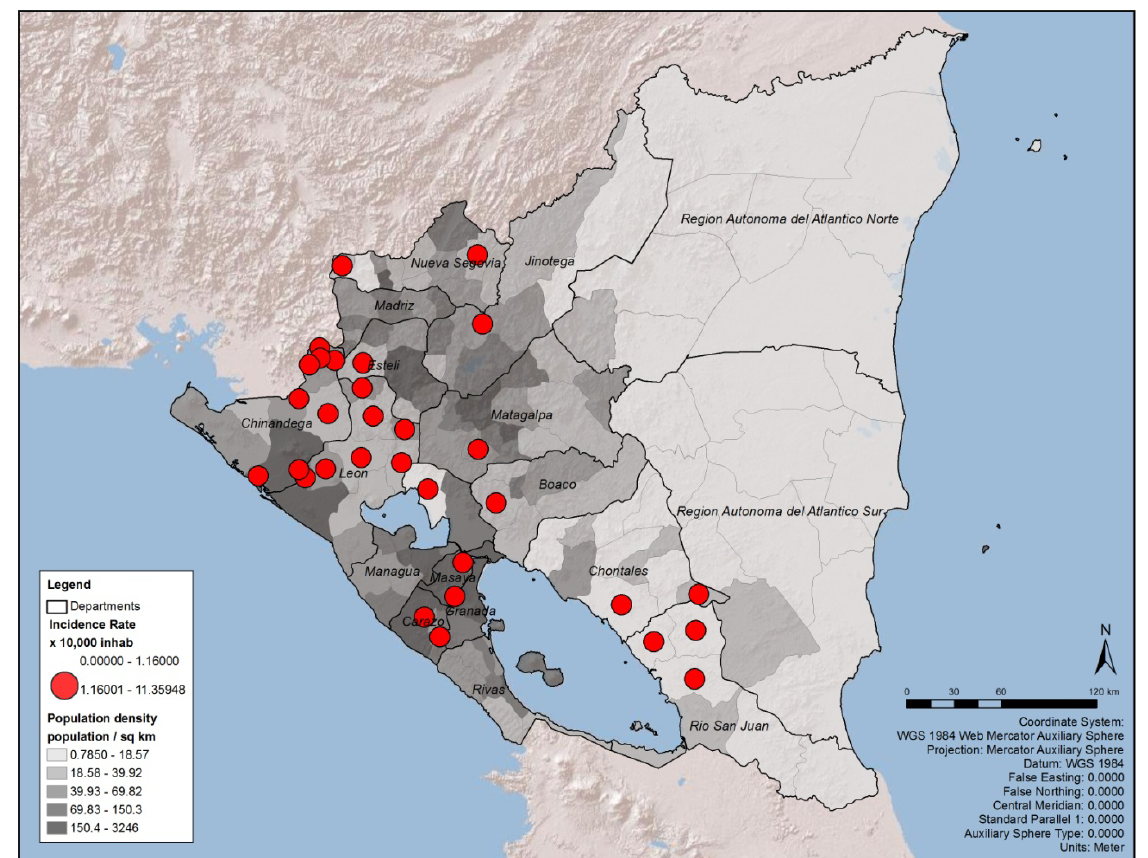
Figure 8. Critical areas for leptospirosis define by incidence rate and population density, Nicaragua, by municipality 2004–2010.